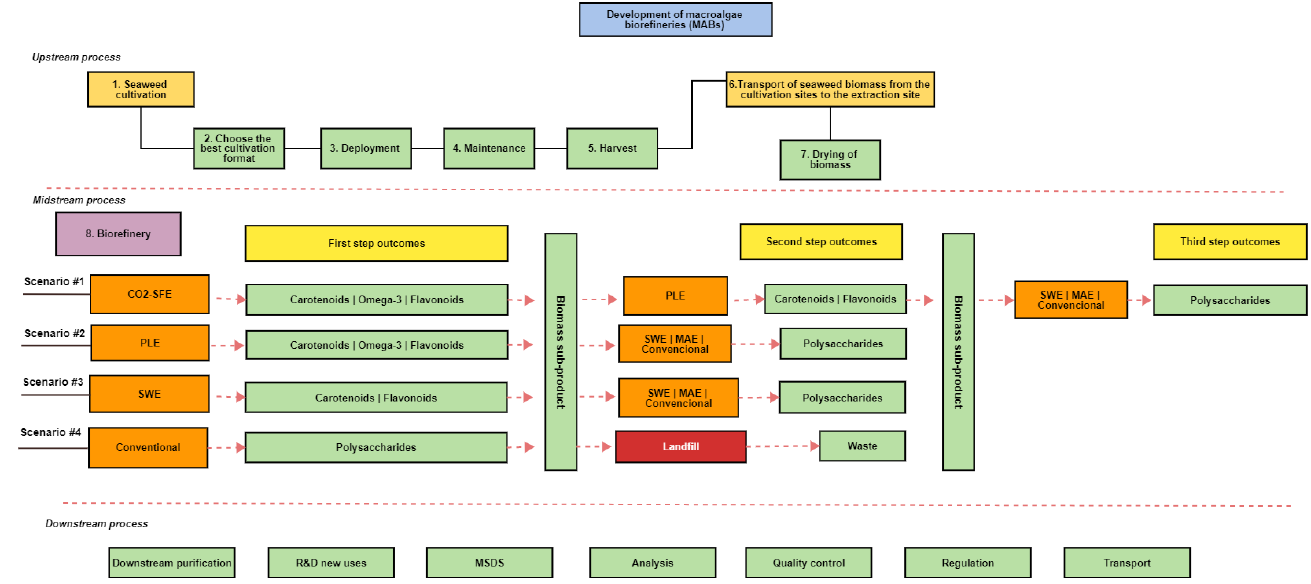
Figure 7. Illustrative scenarios of integrated biorefineries involving macroalgae biomass processing with green technologies.